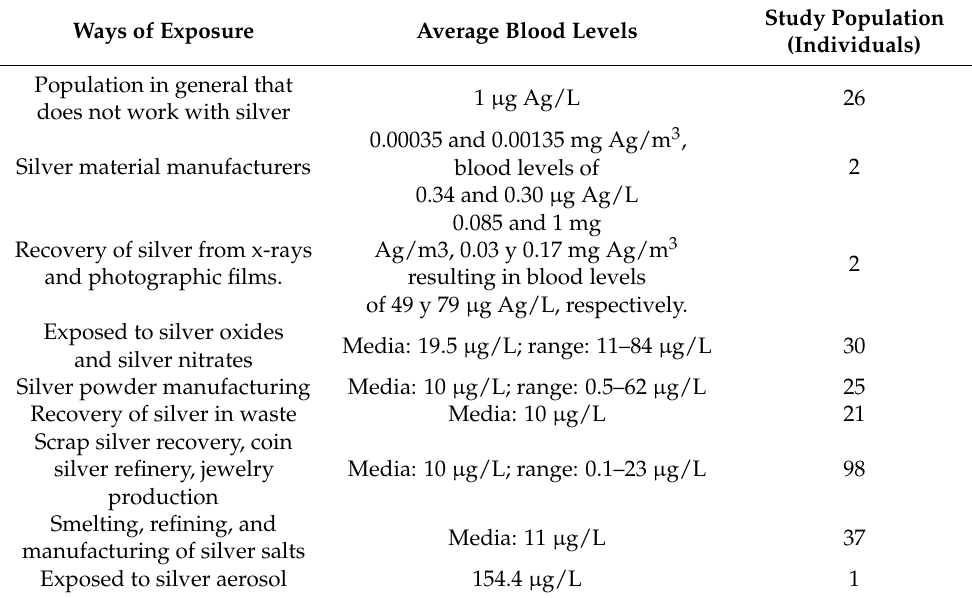
Table 3. Occupational exposure to different forms of silver. Ways of Exposure Average Blood Levels Population in general that